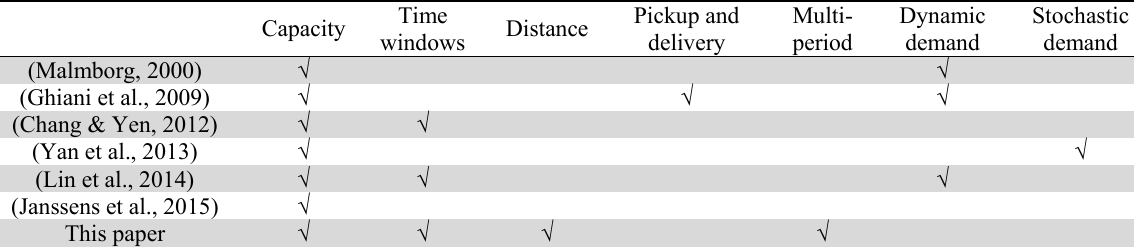
Literature of application of VRP in courier